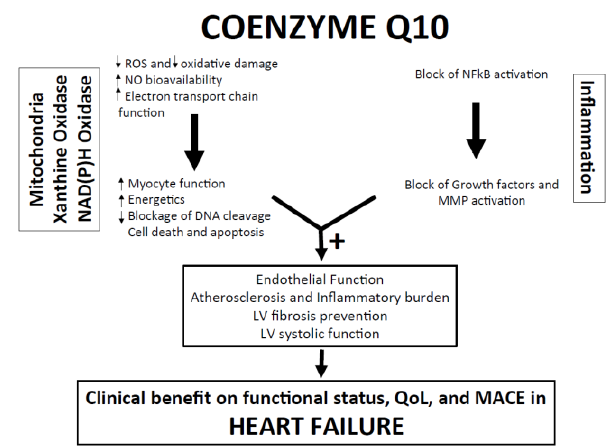
Figure 1. Pathophysiological mechanisms and potential clinical benefits of CoQ10 in heart failure. LV